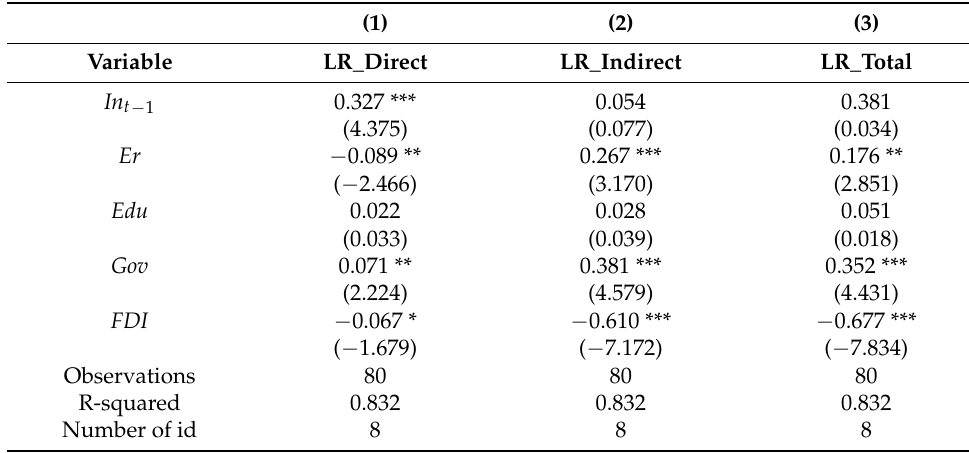
Table 7. Estimates for central region.